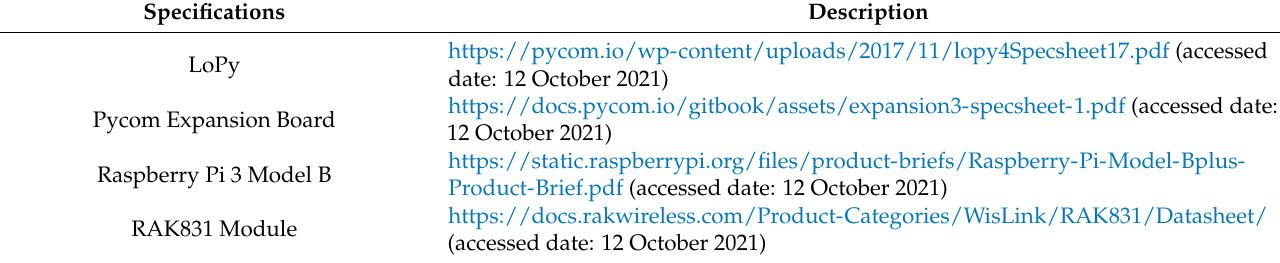
Table 8. Links to Table 8. Links to Datasheets.